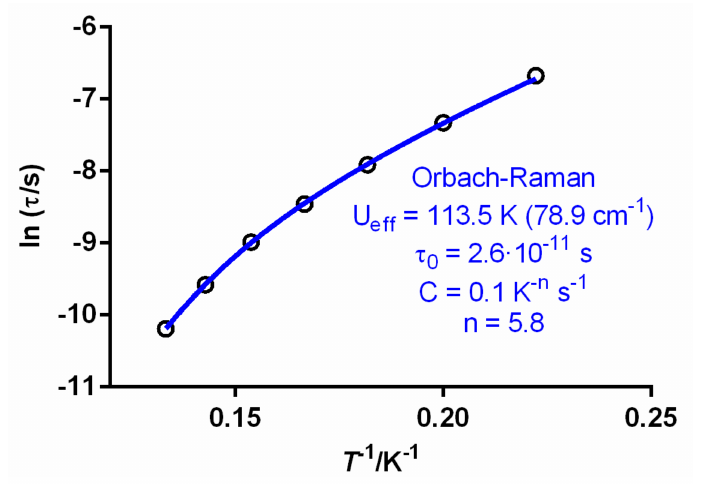
Figure 4. Variation of χ ” M with the frequency for 1 under a dc external field of 1500 Oe at temperatures ranging between 4.5 and 8 K.